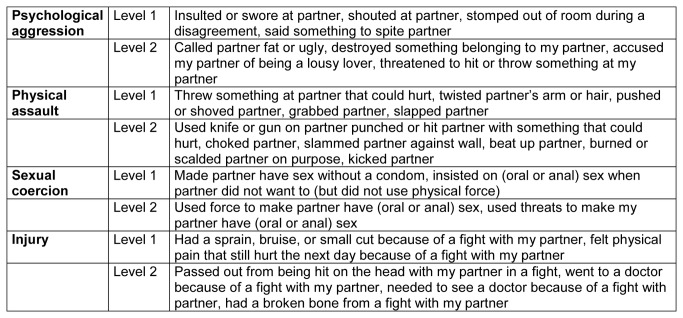
Items and subscales of the Revised Conflict Tactics Scale.